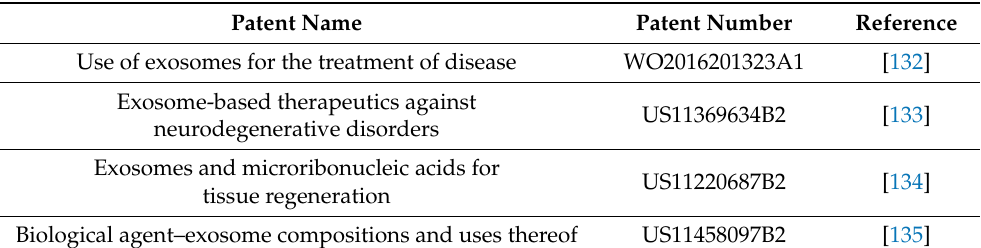
Table 4. List of some therapeutic exosome